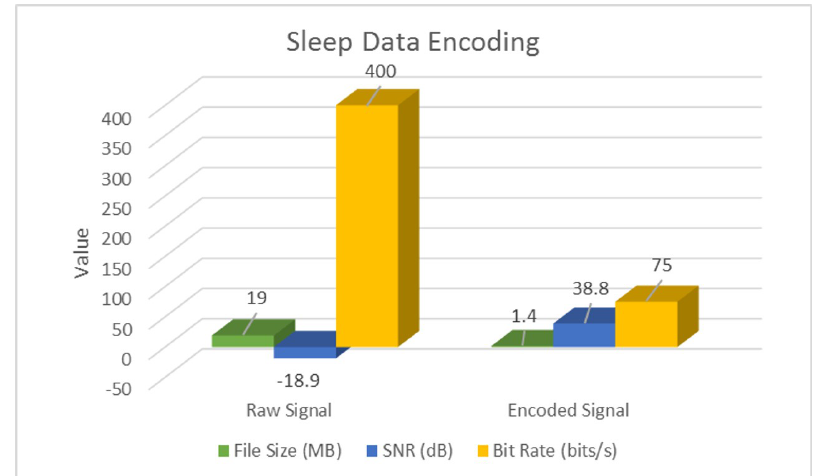
Figure 7. Encoding Sleep actigraphy signals.